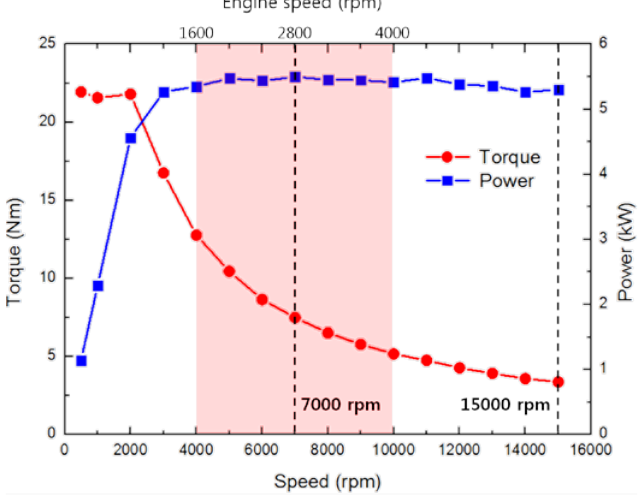
Figure 3. T-N curve under the generating mode of ISG motor.